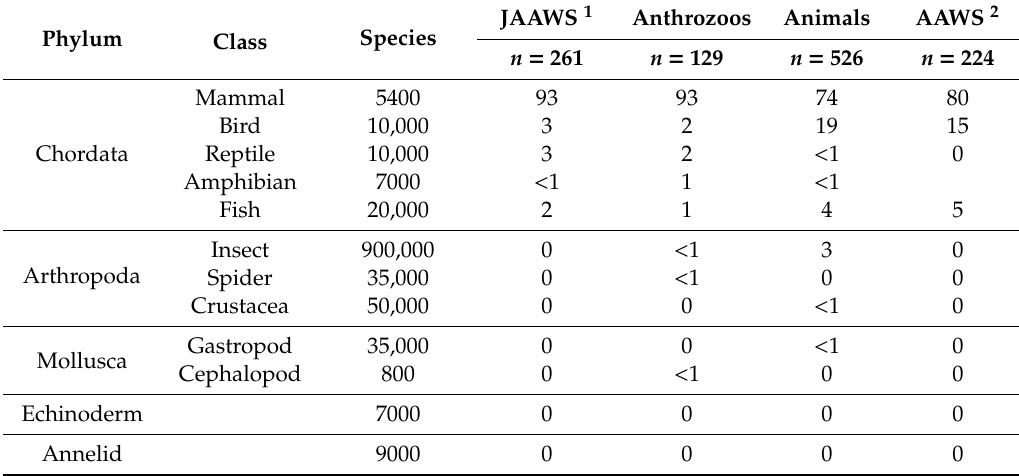
Table 1. Percentage of di ff erent animal groups in recent publications of welfare-related